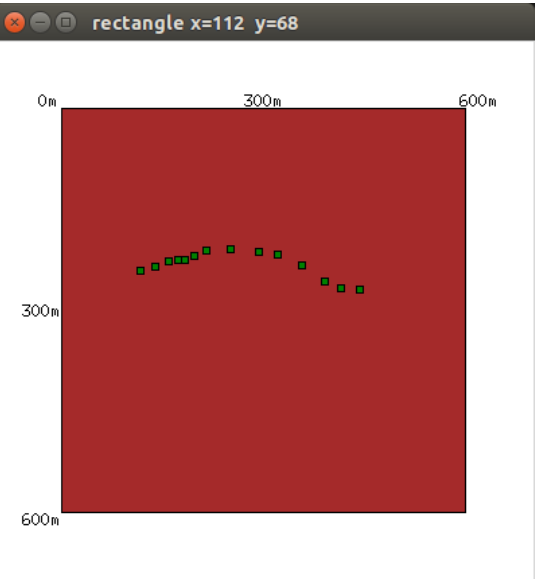
Figure 8. Clickable GUI for generating real-time seismic vibration data.